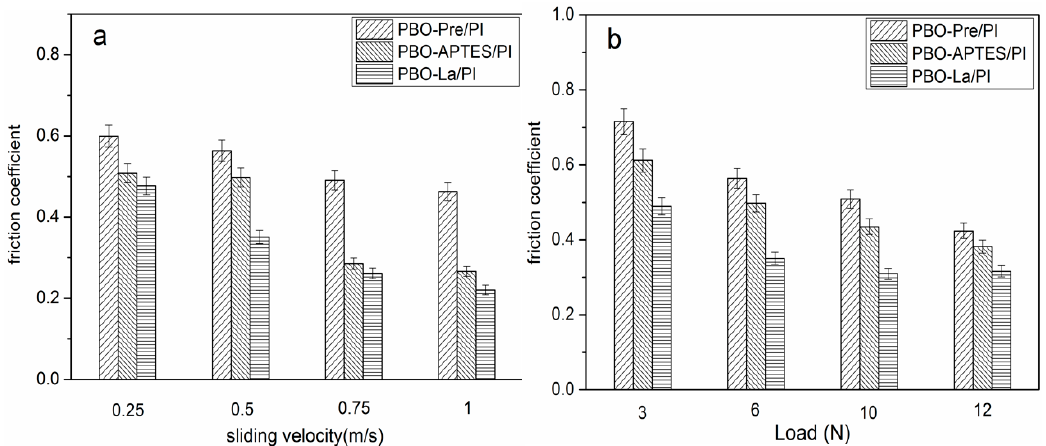
Figure 12. The friction coefficient of PI composites in a 130 °C environment as a function of ( a ) sliding velocity (load: 6 N) and ( b ) load (velocity: 0.5 m/s).